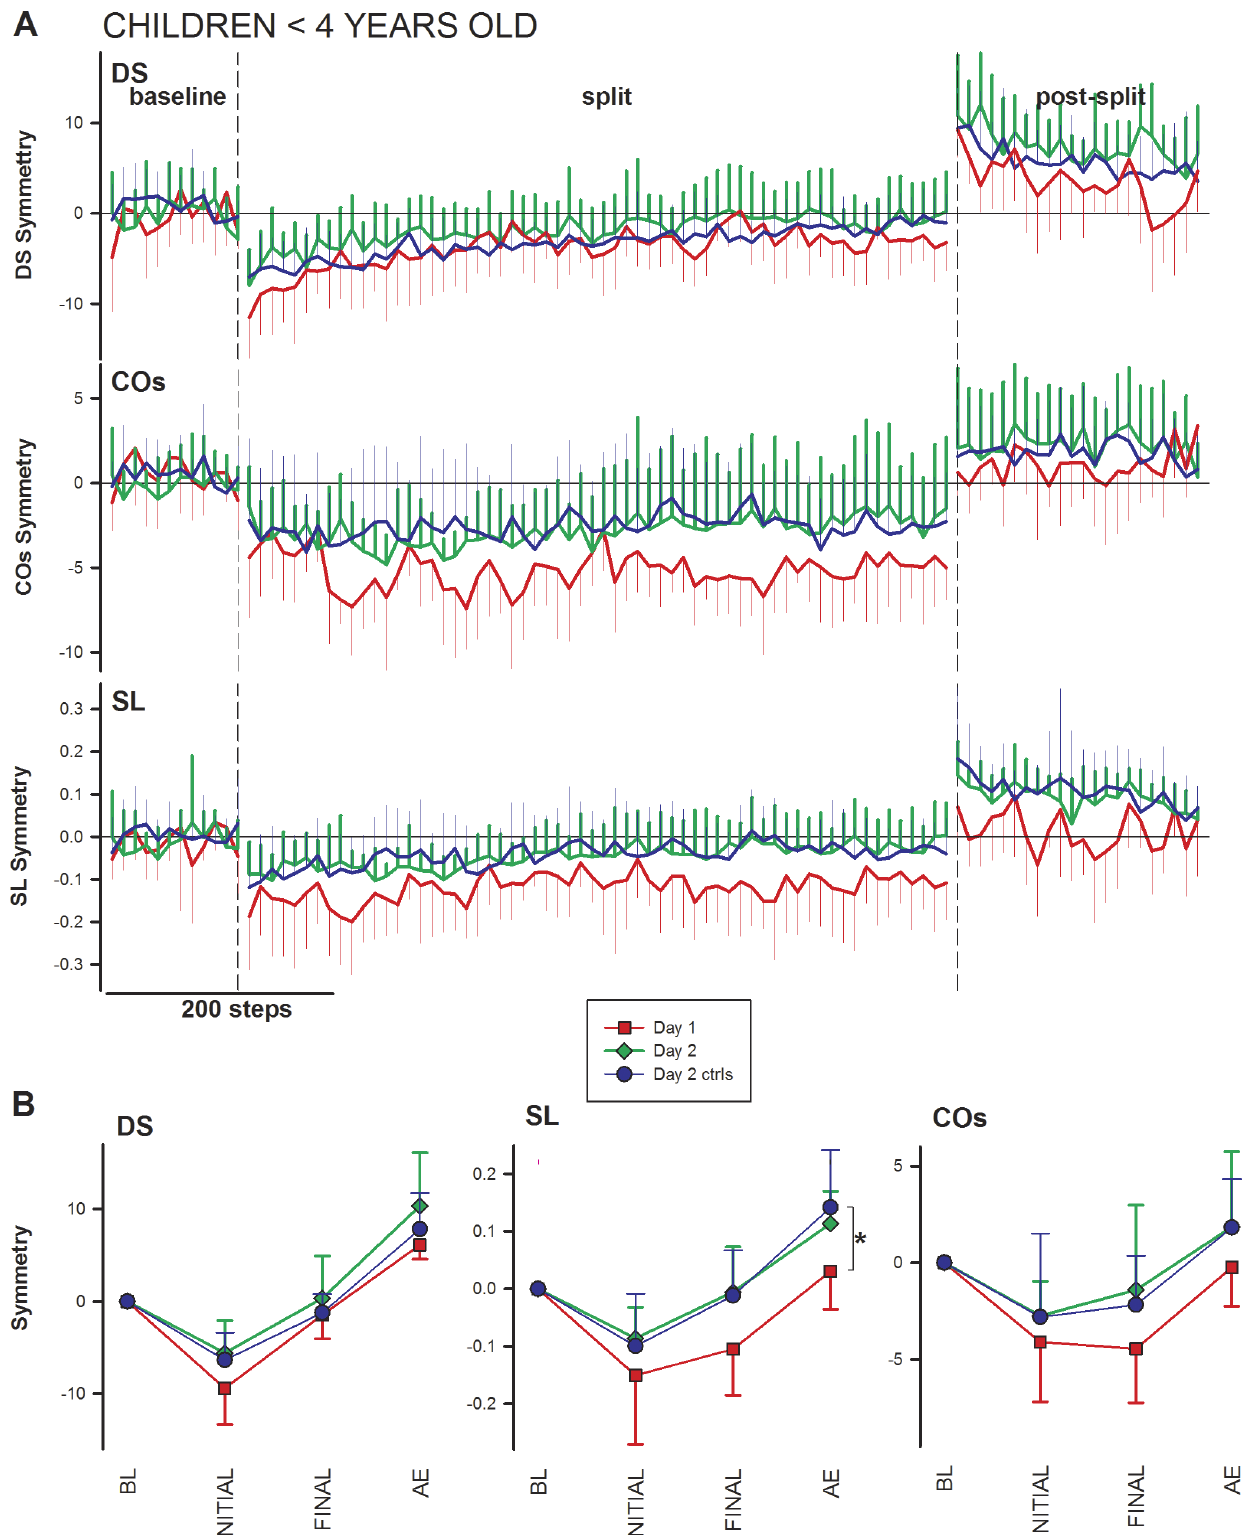
Figure 6. Exposure to tied-belt walking, without perturbation, augments split-belt learning on Day 2 in children , 4 y of age. A. Time courses of walking symmetry in children , 4 y of age, abrupt perturbations only: Ten-step averages are shown for the young children in Experiment 1, Day 1 (i.e., those experiencing an abrupt perturbation 1 st ; red), Day 2 (i.e., those experiencing an abrupt perturbation 2 nd ; green), and the child controls in Experiment 2, Day 2 (blue). The convention of the graph is identical to that of Figure 3. DS – double support; COs – centre of oscillation; SL – step length. B. Comparison of Day 2 control data to Experiment 1, Day 1 and Day 2 data: Symbols represent forty-step averages for